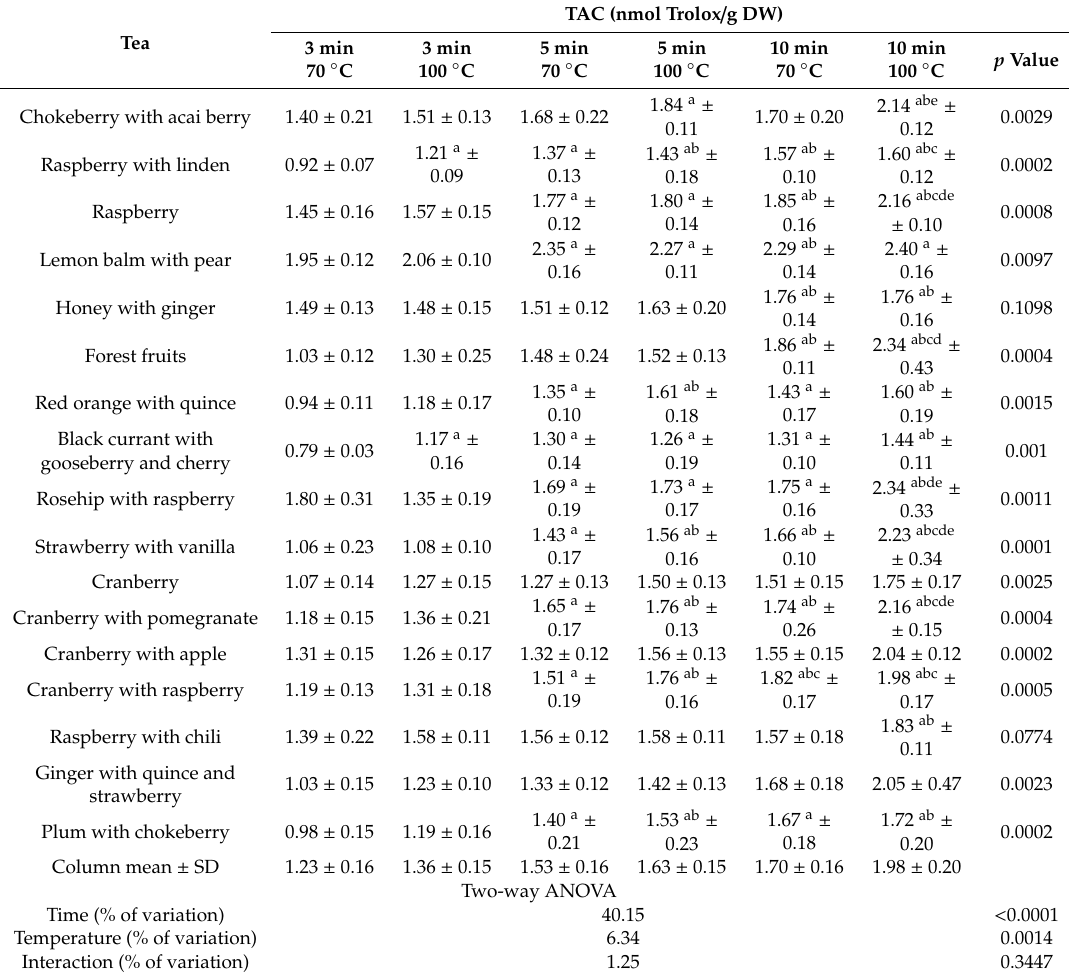
Table 2. Total antioxidant capacity (TAC) in fruit tea infusions. a p < 0.05 vs. 3 min 70 ◦ C; b p < 0.05